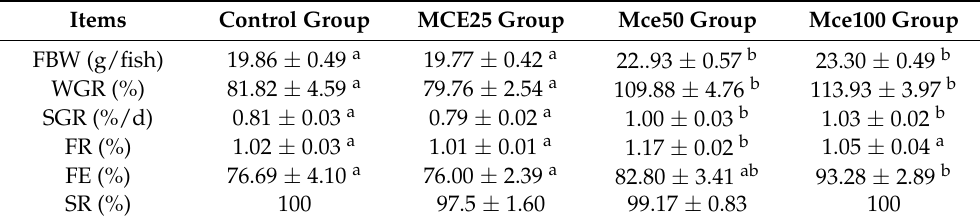
Table 1. Effects of dietary MCE supplementation on growth performance of juvenile American eel.